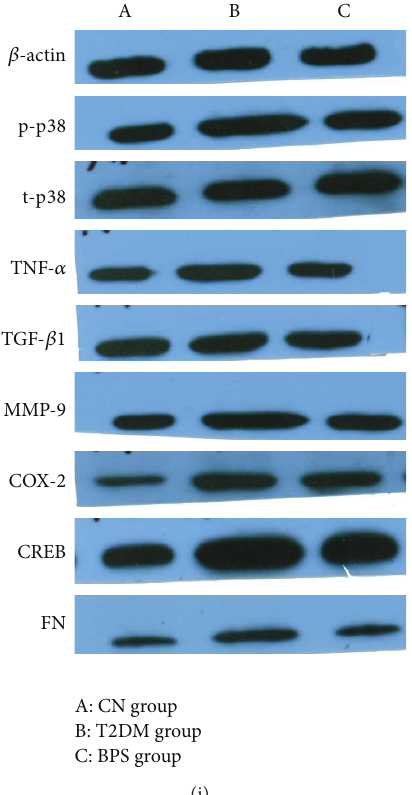
Figure 7: Western blot results of p-p38 (a), t-p38 (b), TNF- 𝛼 (c), TGF- 𝛽 1 (d), MMP-9 (e), COX-2 (f), CREB (g), and FN (h) in CN group rats, T2DM group rats, and BPS group rats. As bar graph, data are mean ± SD of 6 rats. ∗ 𝑃 < 0.05 and ∗∗ 𝑃 < 0.01 T2DM group and BPS group versus CN group rats and 󳵻 𝑃 < 0.05 and 󳵻󳵻 𝑃 < 0.01 BPS group versus T2DM